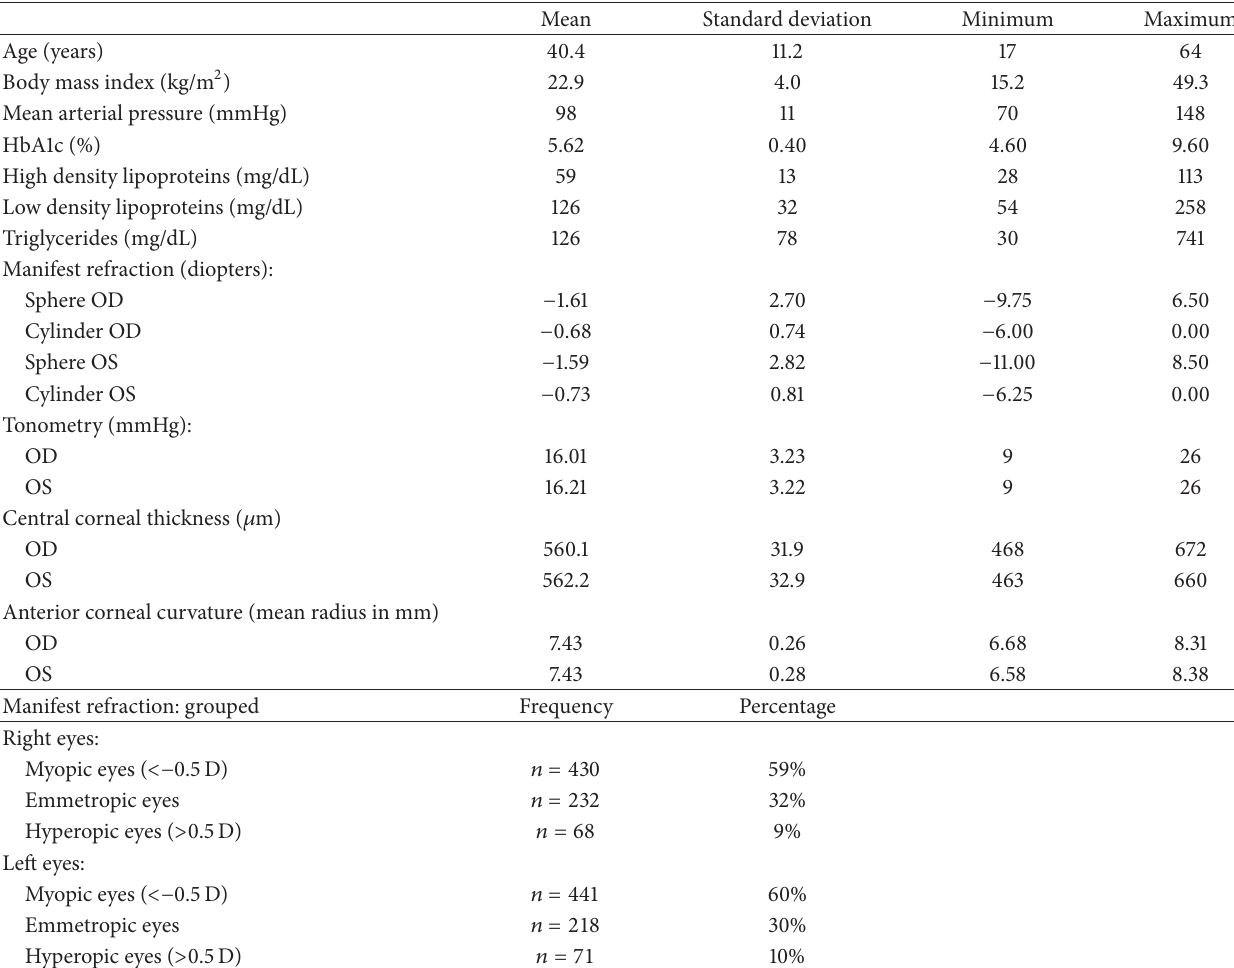
Table 1: Characteristics of the study sample ( 𝑛 = 734 participants). OD: right eyes, OS: left eyes; myopic, emmetropic, and hyperopic eyes classified according to spherical equivalent